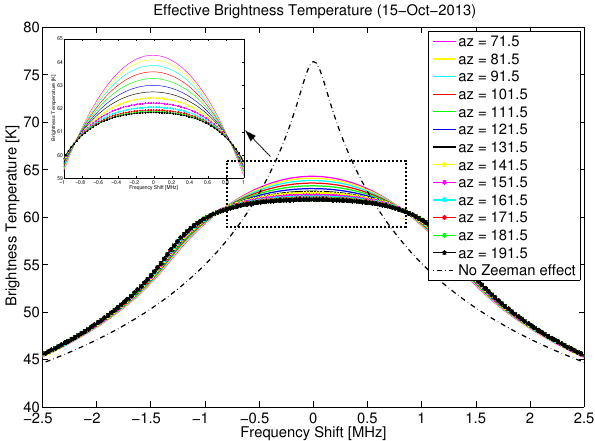
Figure 8. Simulated effective brightness temperature, taking into account that the radiation passed through the different TEMPERA components.